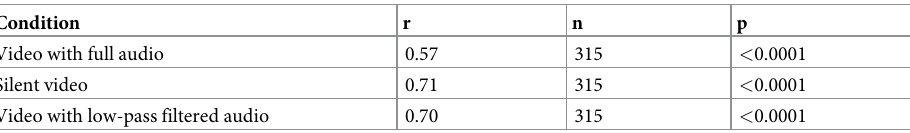
Table 3. Correlations between LORP F1 and F2